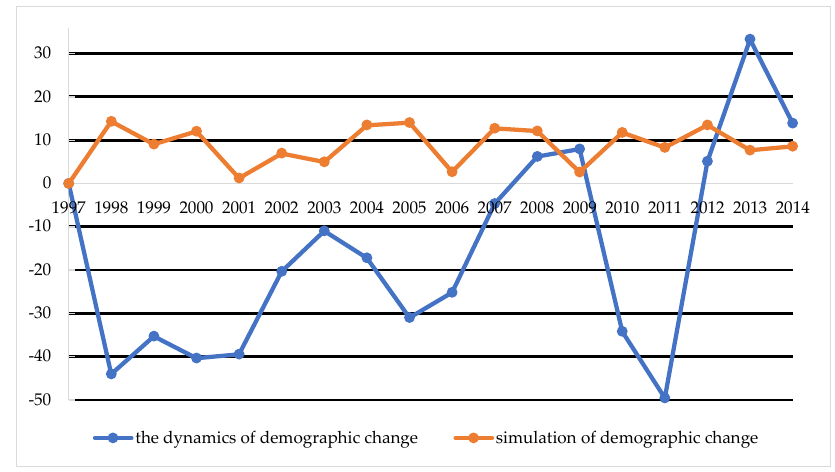
Figure 5. The dynamics of demographic change in Vilnius in the years 1997 – 2014. Source: own study based on CSO, EUROSTAT, LSD [24 – 28,36].